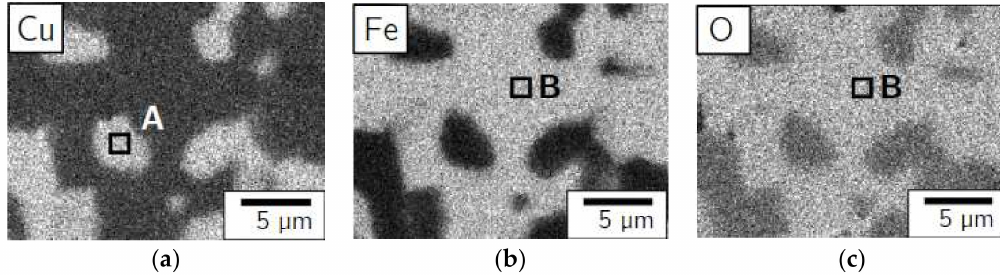
Table 1. While the deviation of oxygen in EDX spectroscopy can be up to 3 mol %, the results provide a rough estimation of the phase compositions.